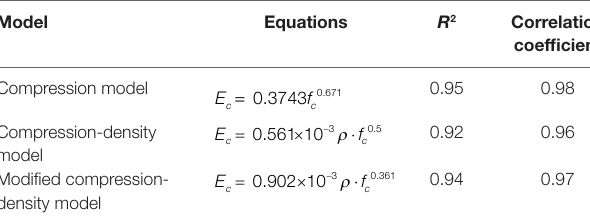
Table 5 | The regression equations of models predicting modulus of elasticity. Model equations R 2 correlation